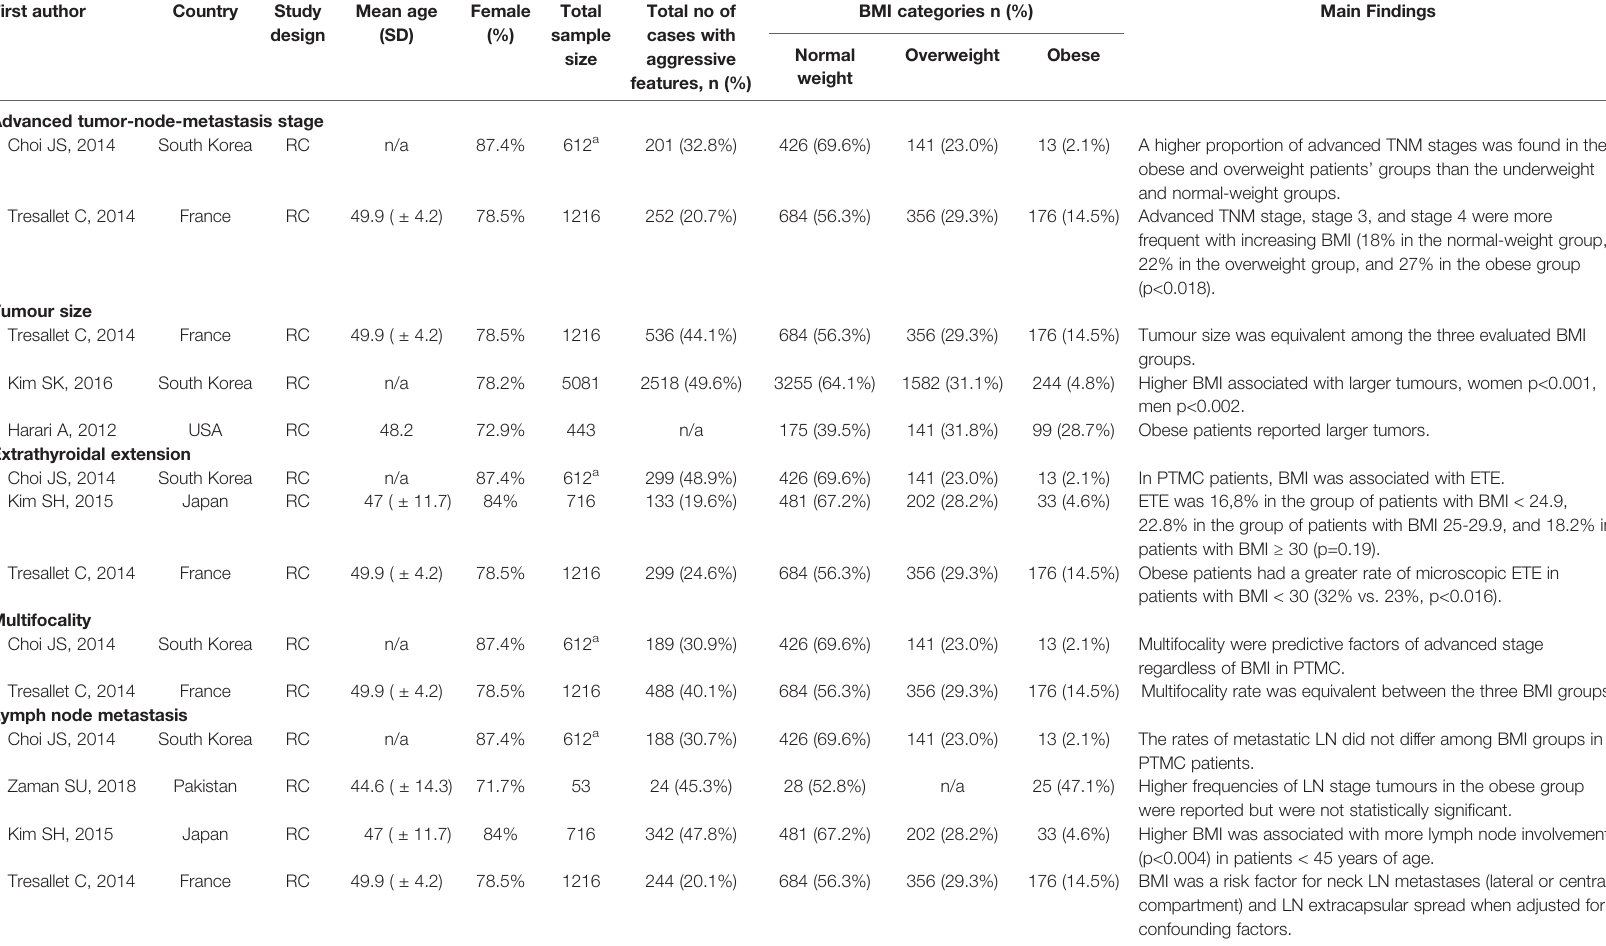
TABLE 1 | Characteristics of studies included in the qualitative